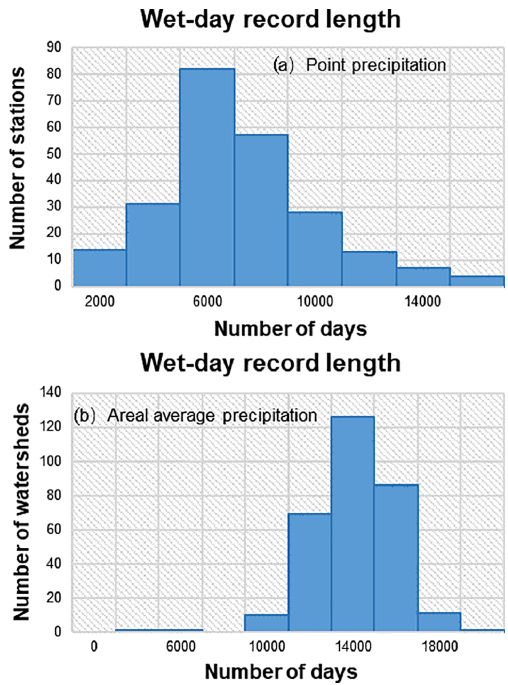
Figure 3. Distribution of wet-day record length: (a) point precipita- tion and (b) areal average precipitation over watersheds. Days with zero precipitation are removed in the wet-day records.